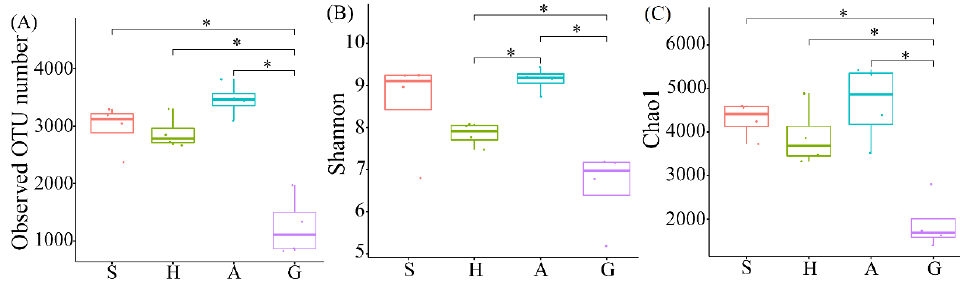
Table 1. Similarity and ANOSIM/Adonis analyses of microbial communities in intestine and sediment samples based on Bray-Curtis dissimilarity.